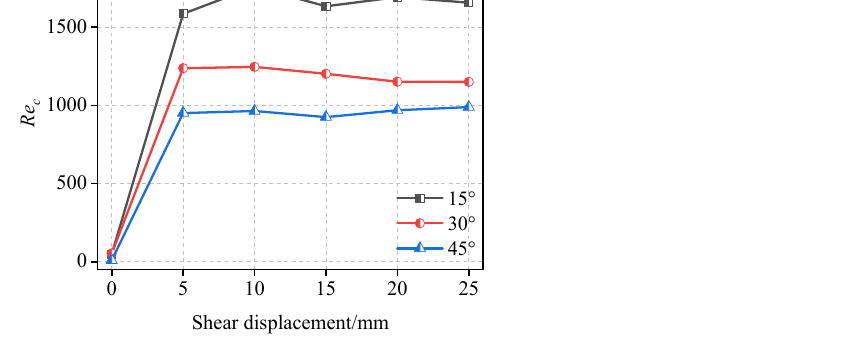
Figure 8. Plot showing critical Reynolds numbers associated with shear displacement of the structural plane.